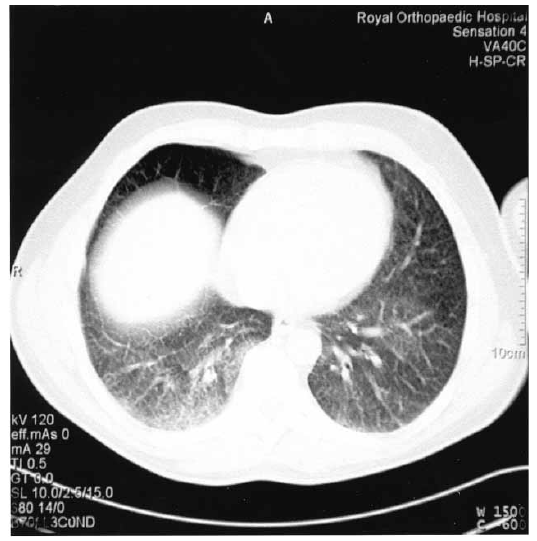
Figure 3. Computed tomography of the chest. This shows lung window images of lung bases showing reticulo-nodular pattern. These ill-defined changes are suggestive of interstitial lung disease though miliary metastases are difficult to rule